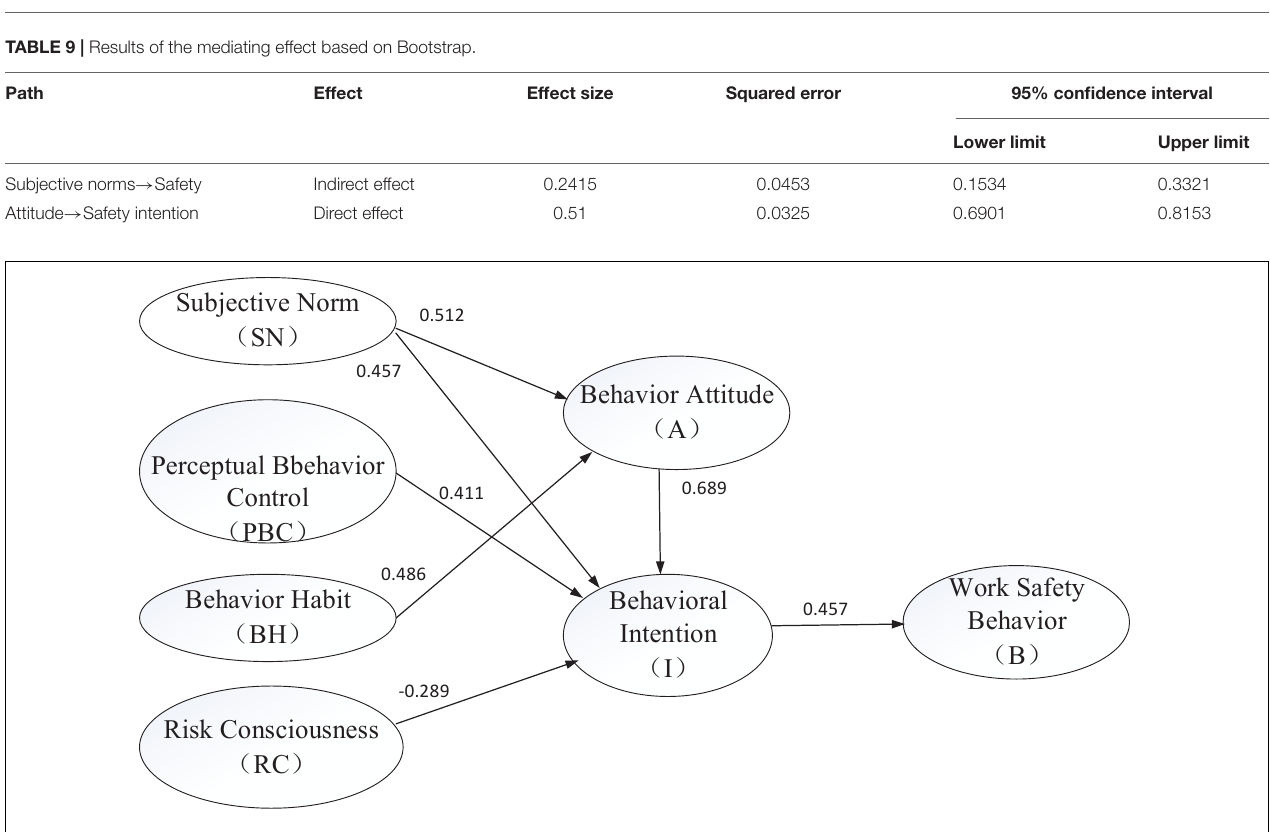
FIGURE 3 | Influence mechanism model of the work safety behaviors of MSEs based on the theory of planned behavior in high-risk industries.